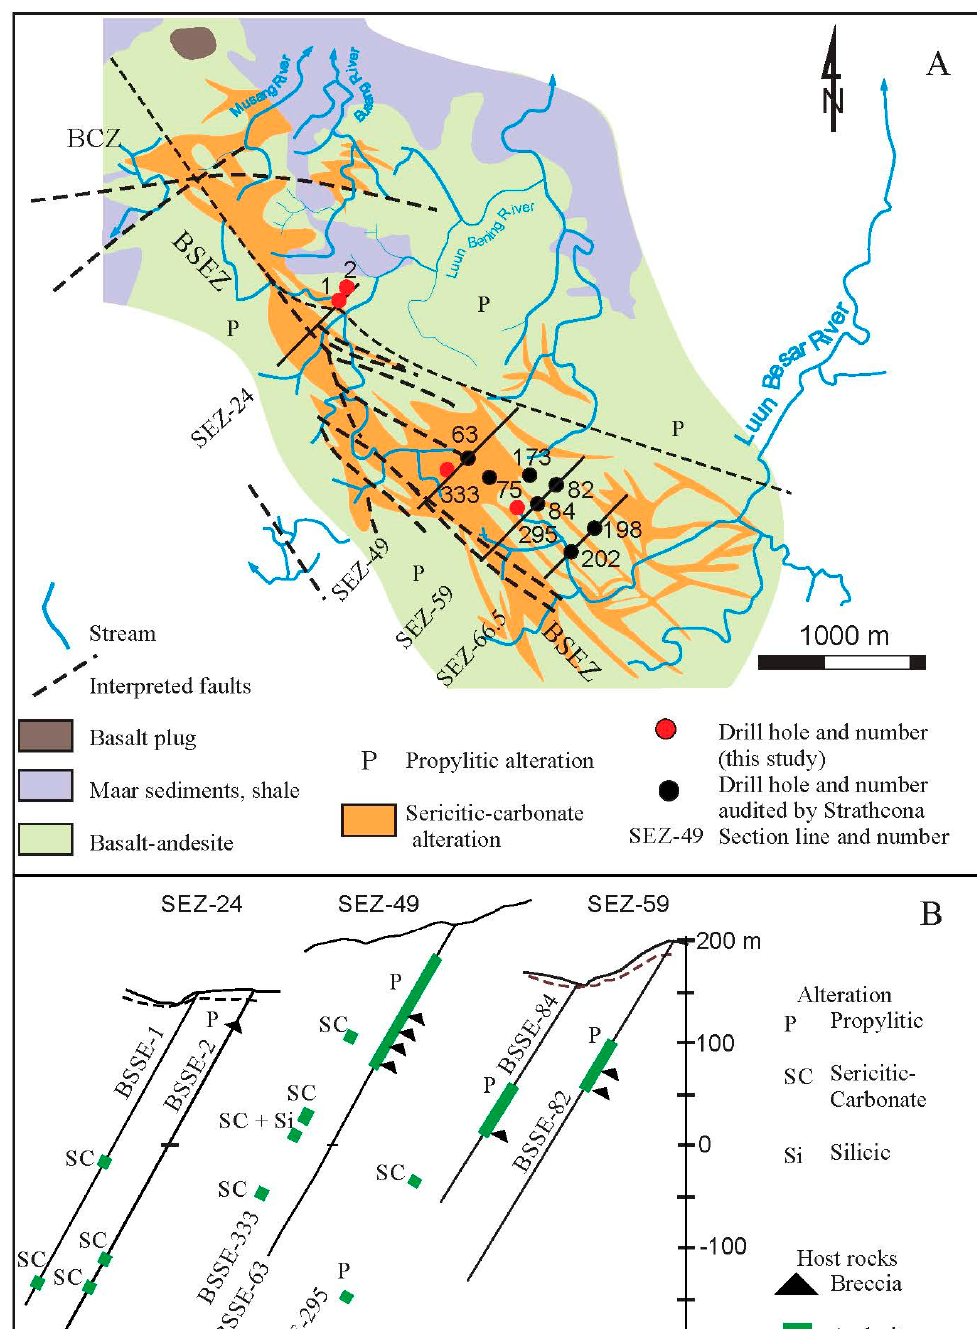
Figure 3. ( A ) Geology, hydrothermal alteration, “mineralized” zones (Busang Central Zone (BCZ) and Busang Southeast Zone (BSEZ)), and relevant drill collars of the Busang prospect (after [2,25], including drill holes BSSE-63, 82, 84 audited by Farquharson [4] and used in this study (BSSE-1, 2, 295, 333). ( B ) Northwest-looking cross-sections of drill holes showing the subsurface porphyritic andesite and alteration of the study area.